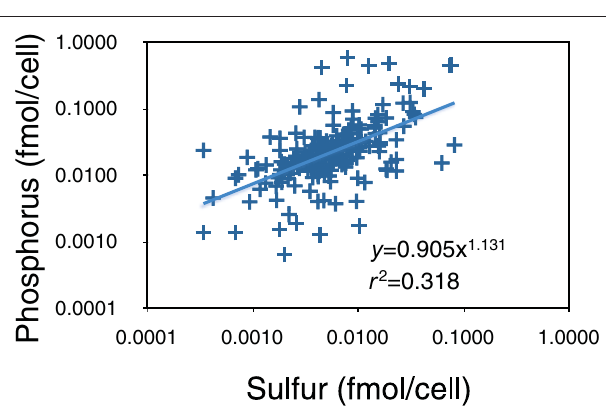
Figure 4 | Frequency histograms of the upper Midwest survey lakes (A,C,e) and Lake Myravatnet (B,D,F) showing C:N, C:P, and N:P (molar) ratios.